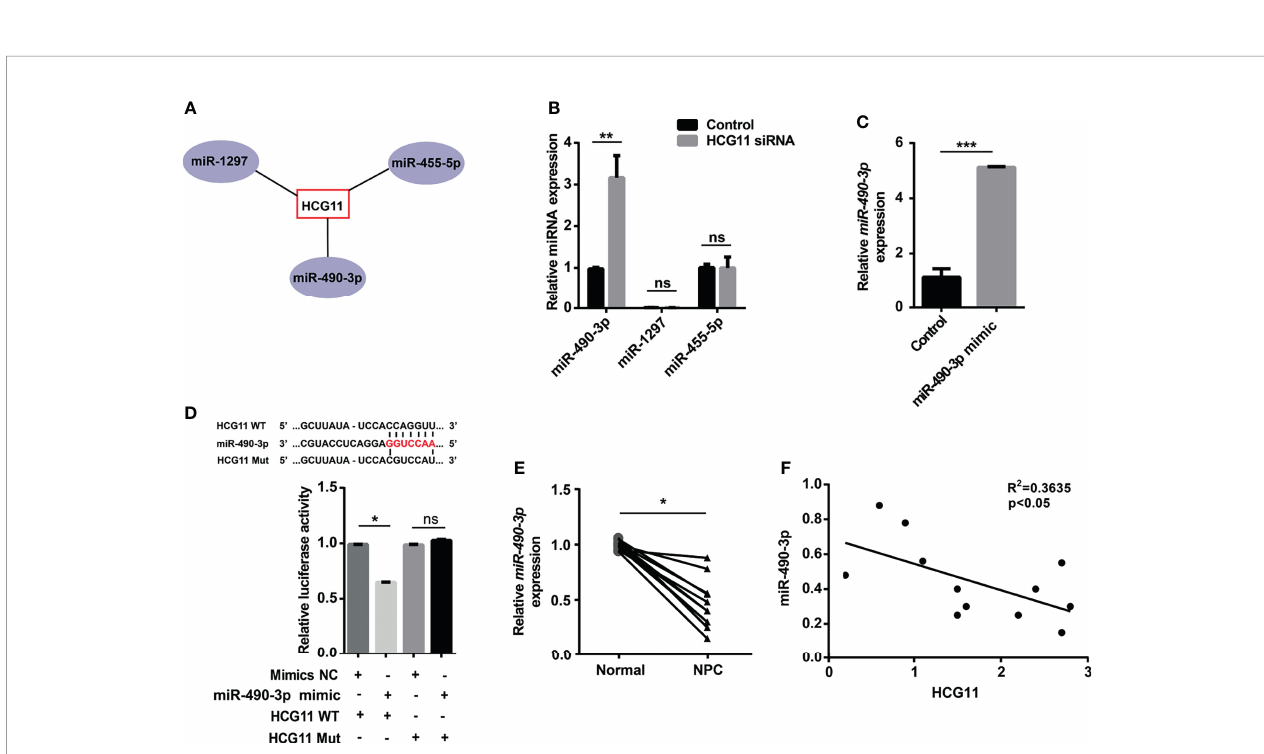
FIGURE 5 | miR-490-3p is a downstream target of HCG11. (A) Bioinformatics analysis of miRNAs targets of HCG11. (B) QPCR analysis of miR-490-3p, miR-1297 and miR-455-5p level in 5-8F cells transferred with HCG11 siRNA and control siRNA. (C) QPCR analysis of miR-490-3p in 5-8F cells (Control, miR-490-3p mimic). (D) 5-8F cells were co-transfected with PGL3-CMV-LUC-lncRNA HCG11 WT (HCG11 WT) or PGL3-CMV-LUC-lncRNA HCG11 mutant (HCG Mut) and control or miR-490-3p mimic. Luciferase activity of HCG11 WT or HCG11 Mut was determined. (E) QPCR analysis of miR-490-3p in NPC tissues and adjacent tissues (n=12). (F) Correlation between HCG11 expression and miR-490-3p was performed in NPC tissues. Data were presented as Mean ± SEM. Ns, p > 0.05, * p < 0.05, ** p < 0.01, *** p < 0.001. These experiments were repeated for three times (B – D)